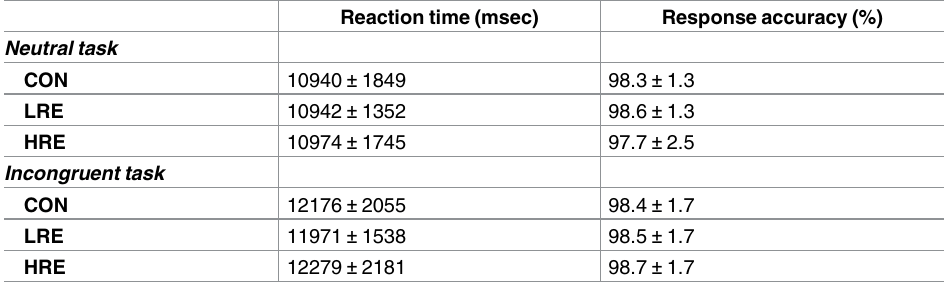
Table 1. Baseline data for the results of the color-word Stroop task